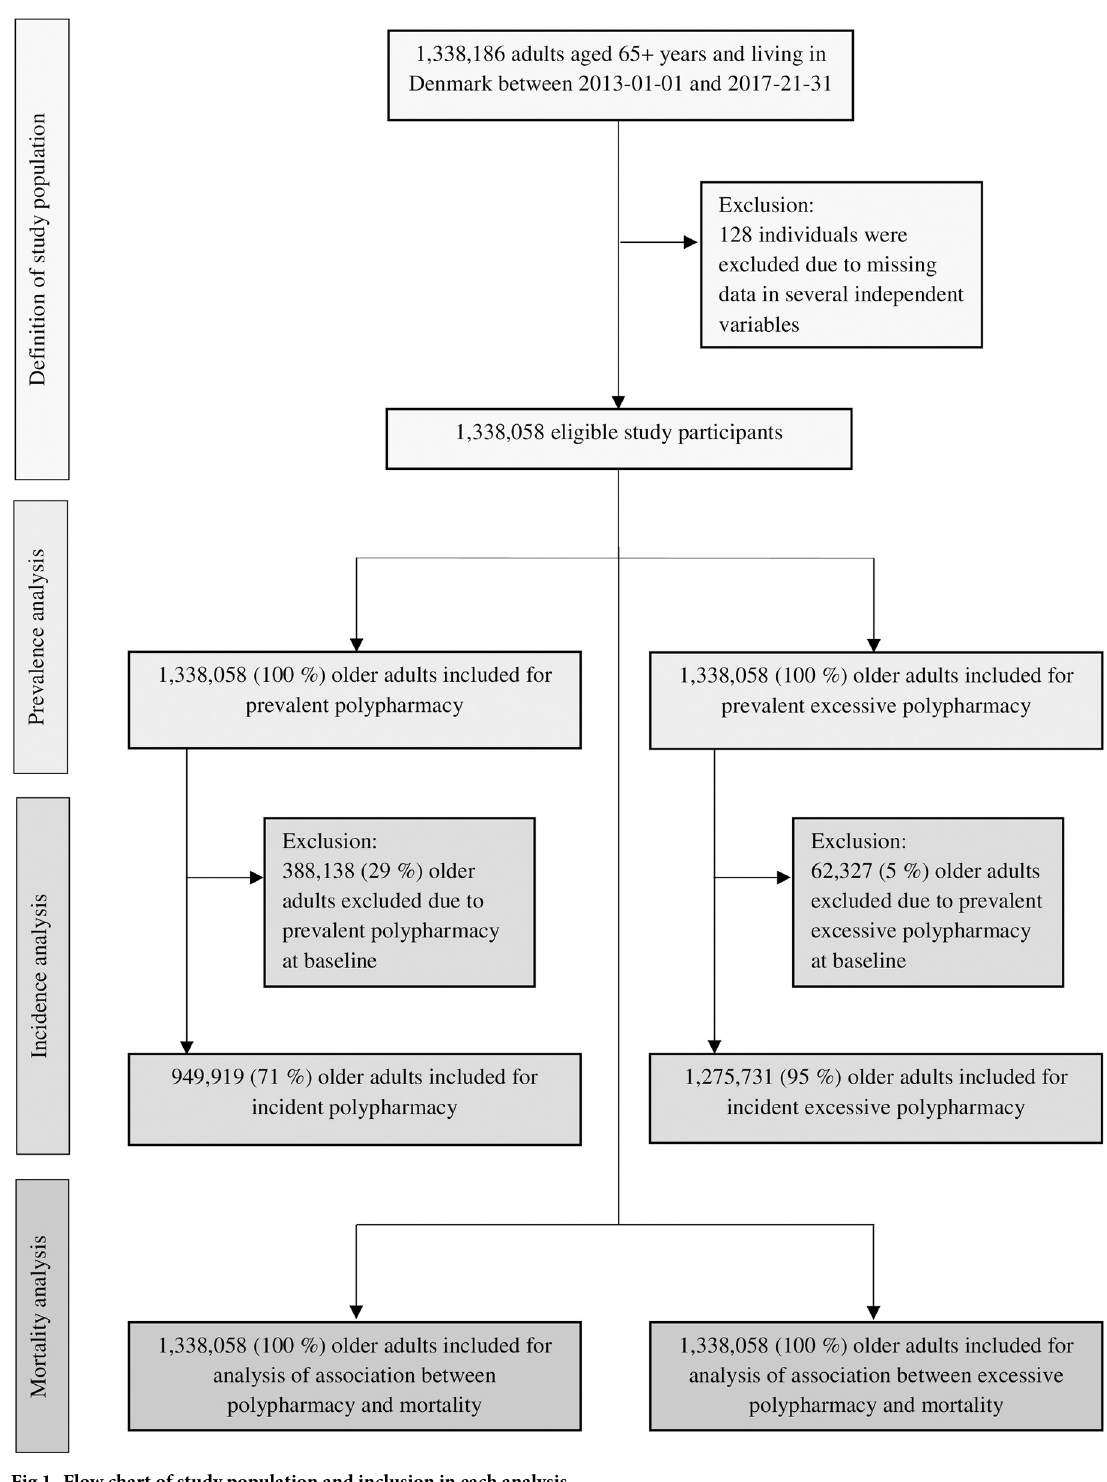
Fig 1. Flow chart of study population and inclusion in each analysis.